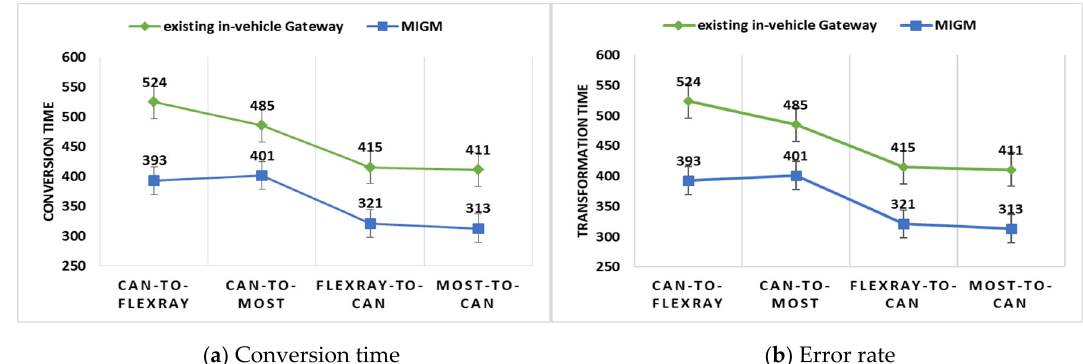
Figure 13. The ( a ) conversion time and ( b ) an error rate per protocol.